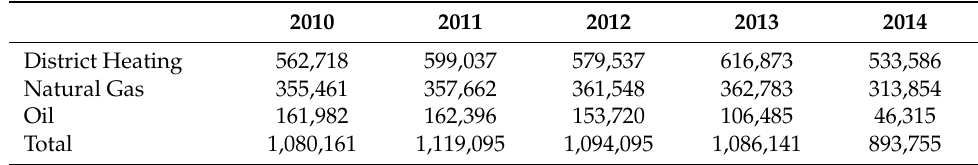
Table 1. Frequency of measurements categorised by heat supply type and year.